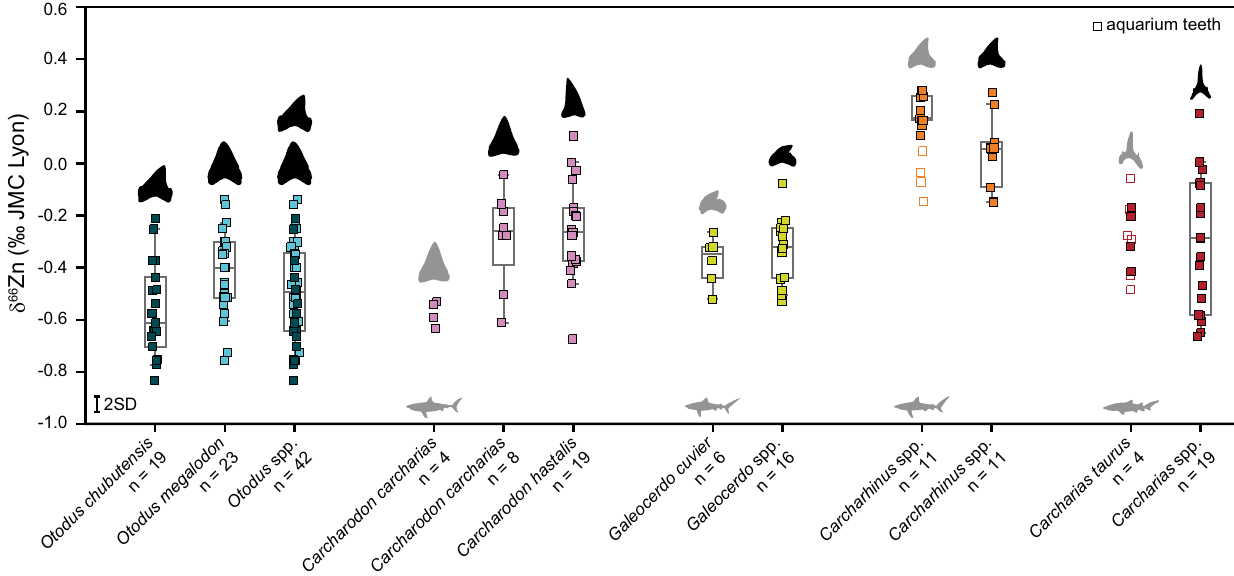
Fig. 3 Zinc isotope ( δ 66 Zn) composition of fossil and extant elasmobranch enameloid of selected taxa combined from Figs. 1 and 2. Fossil teeth are from multiple locations and ages. Grey silhouettes indicate extant teeth. The boxes for n > 5 represent the 25th – 75th percentiles (with the median as a horizontal line) and the whiskers show the 10th – 90th percentiles. Box plots (and n ) do not include aquarium teeth (open squares). Otodus spp. includes all O. chubutensis (dark blue) and O. megalodon teeth (light blue) analysed and samples are otherwise colour-coded following their genus. Silhouettes are not to scale. For more details on the samples, see Figs. 1 and 2 and Supplementary Data 1. Source data are provided as a Source Data fi le. Measurement uncertainty is indicated at the 2 SD